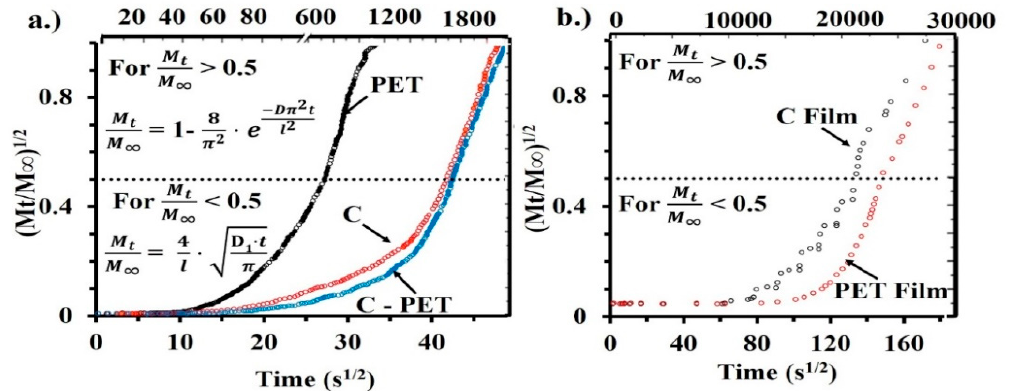
Figure 6. Graphical representation of ( M t / M ∞ ) 1/ 1 / 2 mass changing vs. time 1 / 2 of ( a ) PET, C and C-PET nanofibrous mats and ( b ) PET and C model films.